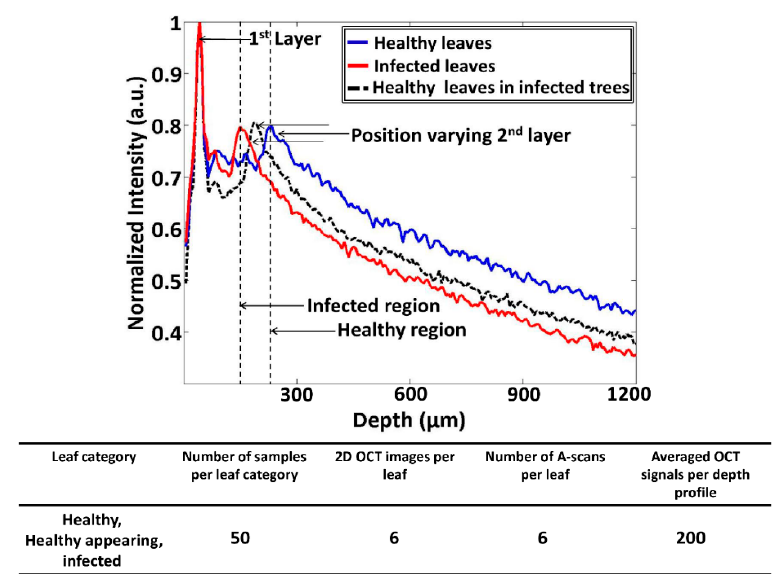
Figure 4. The A-scan profile results comparison for healthy, infected, and healthy-looking leaves